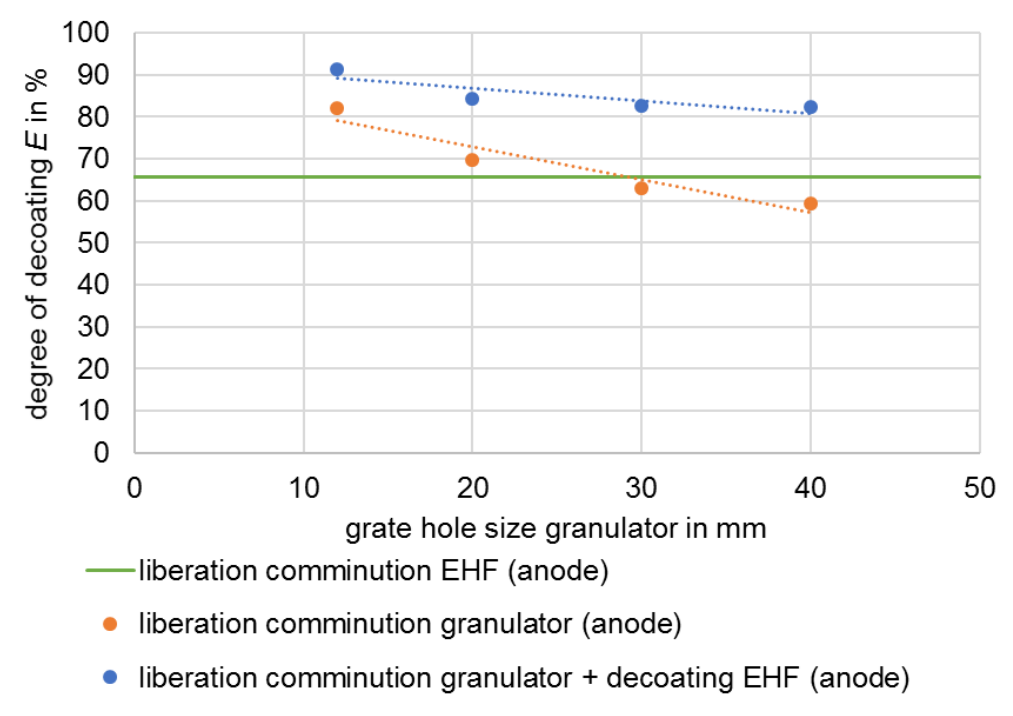
Figure 7. Degree of decoating E of the anode after different stresses.